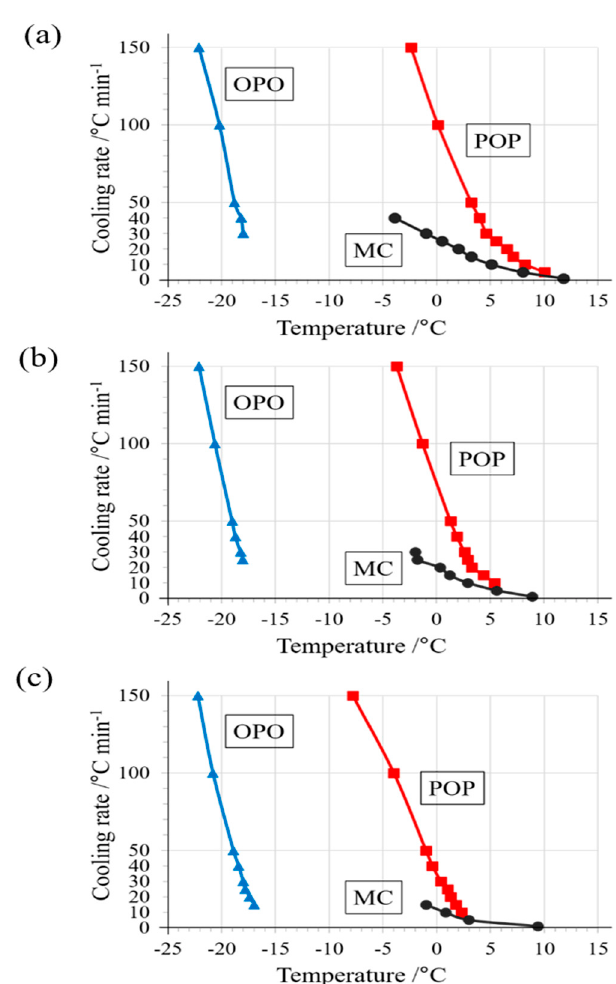
Figure 6. Crystallization temperatures of polymorphs based on DSC exothermic peak top temperatures. Comparing the results of a binary mixture of ( a ) OPO/POP = 4/6, ( b ) 5/5, and ( c ) 6/4. The values of the temperature are represented by circles for MC, red squares for POP, and blue triangles for OPO. Table 2. Polymorphs observed at SR-TXRD results.